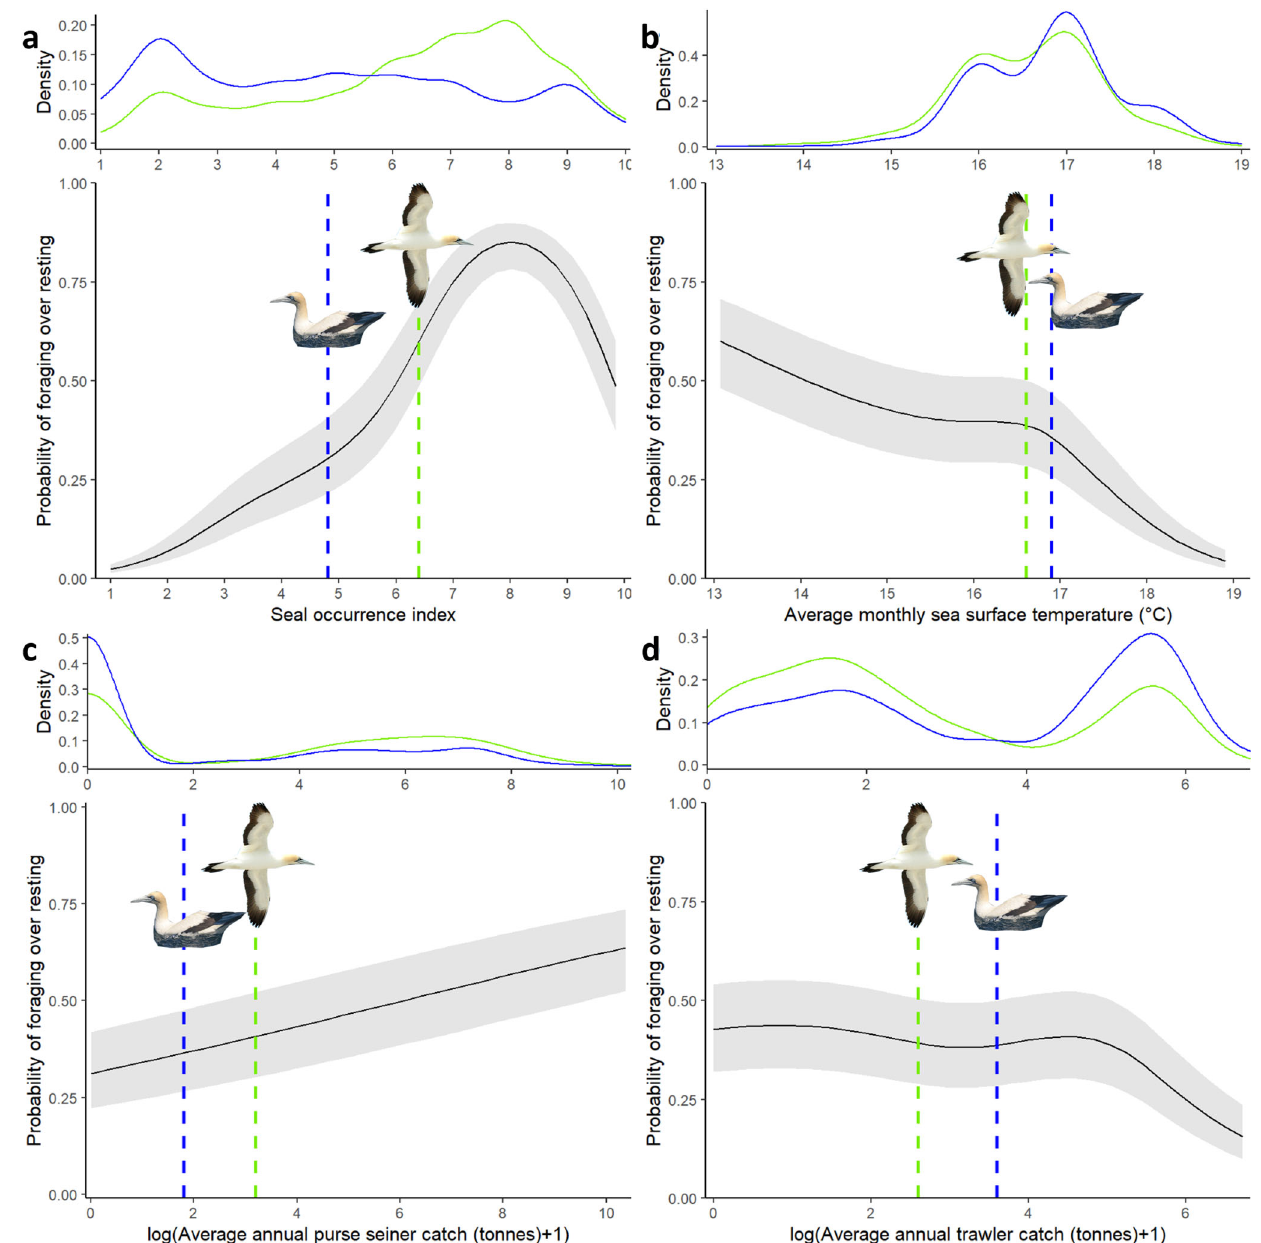
Fig. 4 Probability of daytime foraging over nighttime resting for gannets in relation to environmental features ( n = 142 birds). We predicted the effect of a seal occurrence, b sea surface temperature, c purse-seiner catches, and d trawler catches, with a mixed effect logistic regression and keeping all other covariates at their mean. Grey areas represent the 95% con fi dence interval. The x-axis is back-transformed (unscaled). Distribution and mean (dotted line) are shown for daytime foraging (green) and nighttime resting (blue)